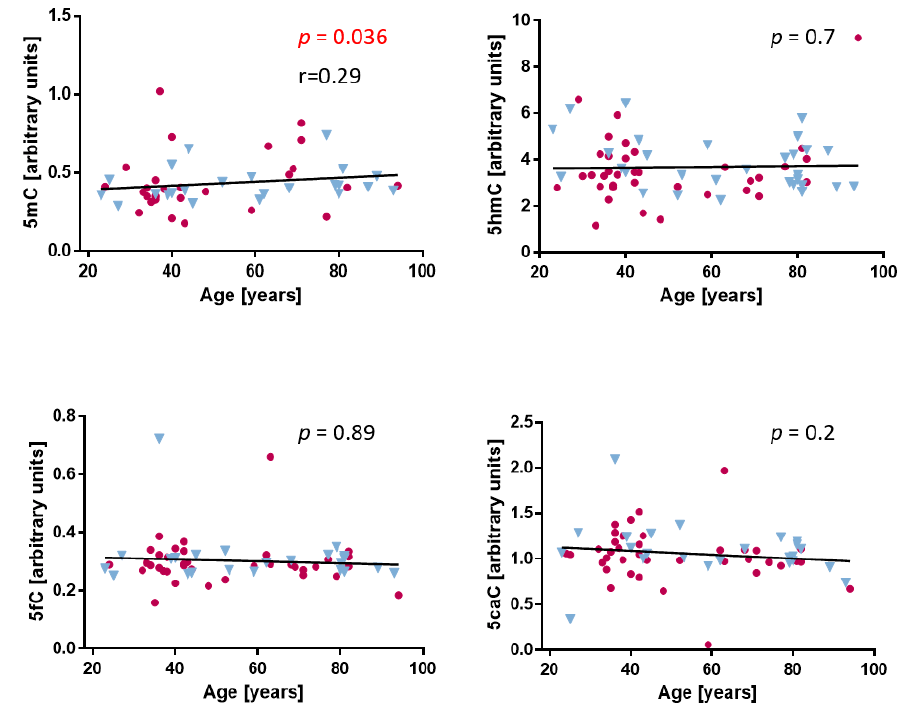
Figure 1. Levels of 5-methylcytosine (5mC), 5-hydroxymethylcytosine (5hmC), 5-formylcytosine (5fC) and 5-carboxylcytosine (5caC) in human dermis. Levels of DNA methylation and demethylation derivatives in the dermis evaluated with the dot-blot method. The statistical analysis was performed with the Mann–Whitney U -test and Spearman’s correlation test. Purple circles: women. Blue triangles: men.